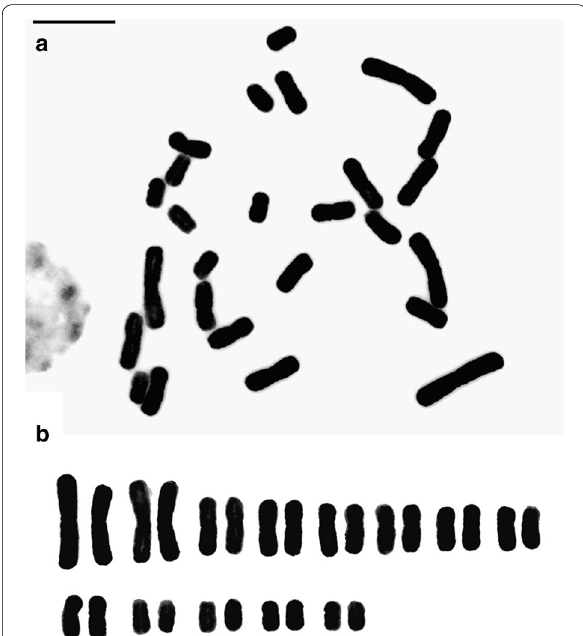
Fig. 3 Karyomorphology of P. rungsuriyanum . a Mitotic chromosome preparation, 2n 26. Scale bar 10 μm. b Karyotype arrangement. = Scale bar 10 μm